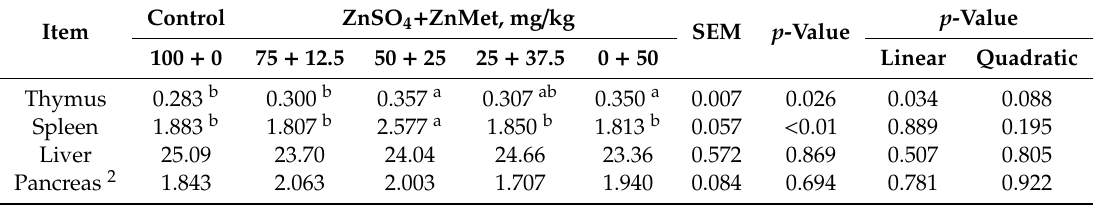
Table 6. E ff ects of dietary substitution of ZnSO 4 by low levels of ZnMet on visceral indices of 37- to -79-d-old piglets 1